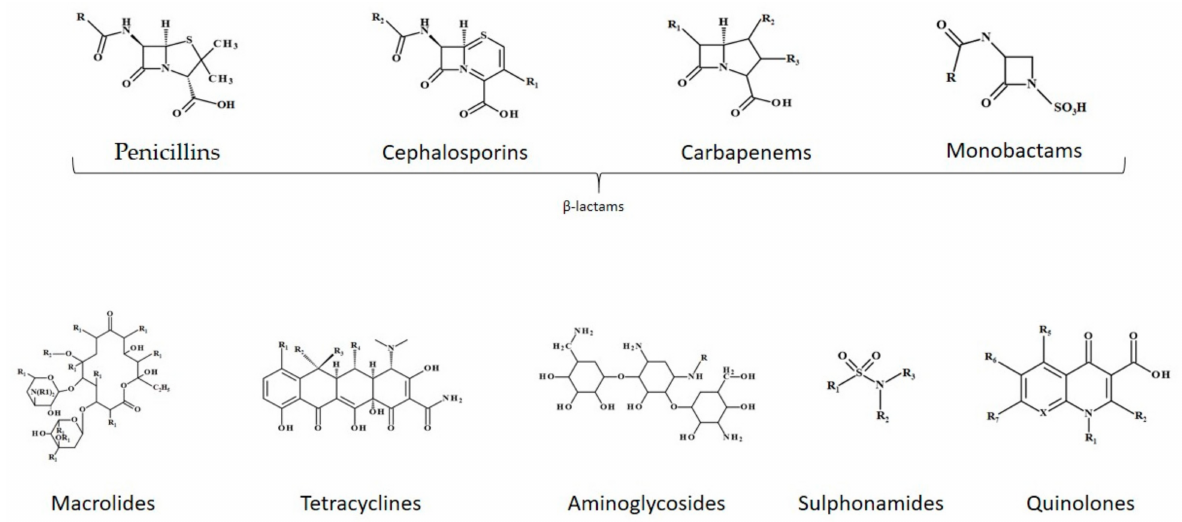
Figure 2. Main classes of antibiotics and their general chemical